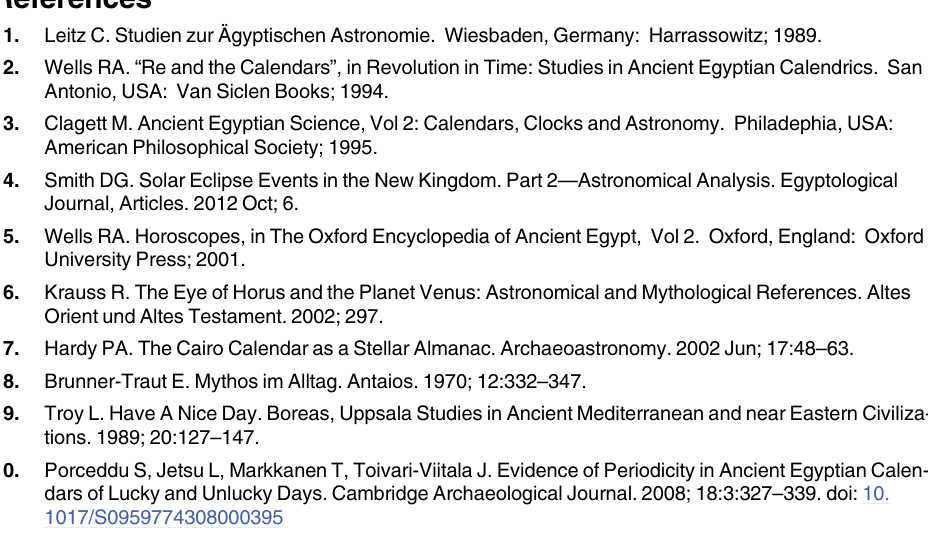
) and unlucky ( s ) time i i ) and differences ΔΘ = R i